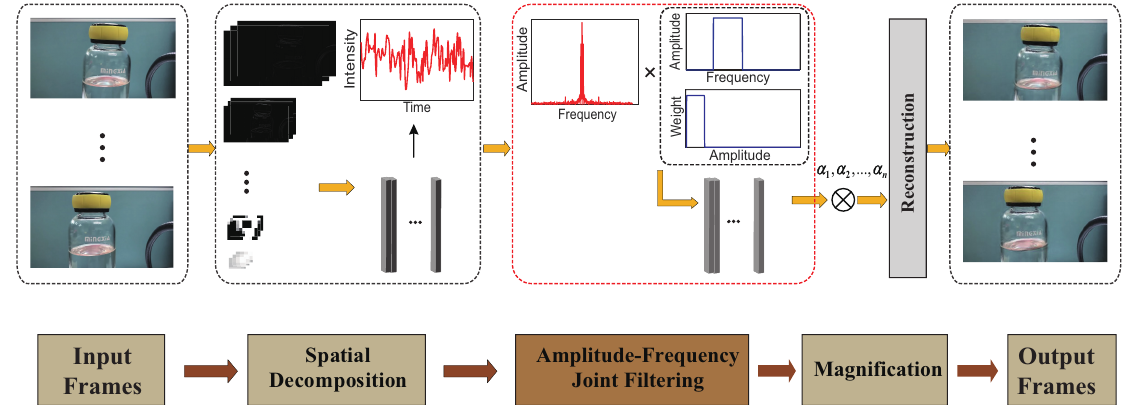
Figure 1. Overview of improved Linear EVM algorithm using amplitude-based